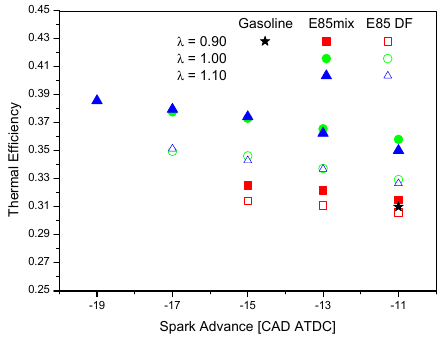
Figure 6. Indicated thermal efficiencies profile against spark advance at different λ .